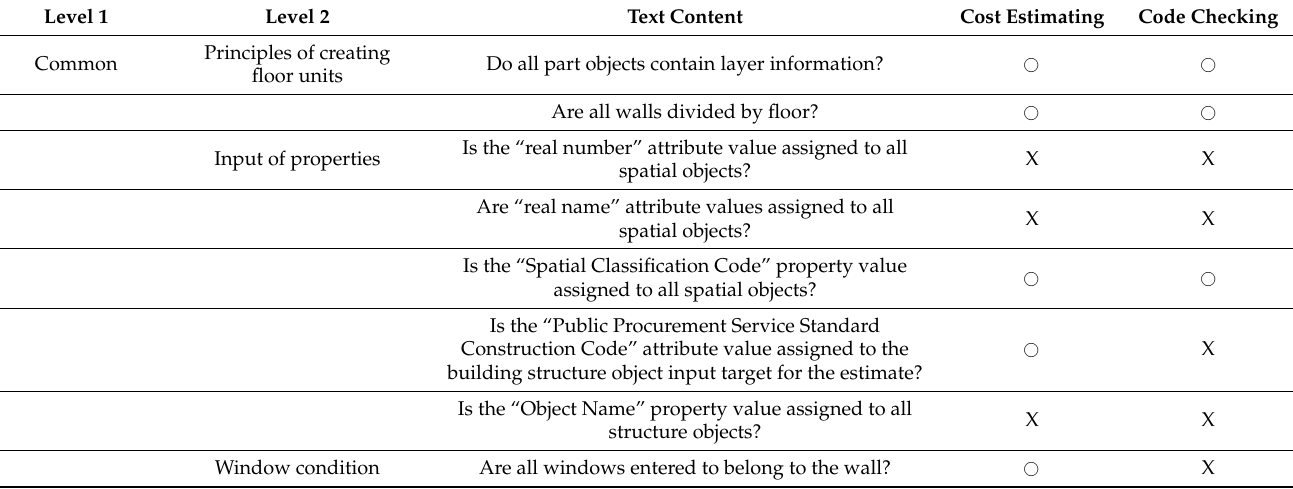
Table 8. Quality Control Layer—Part of the Quality